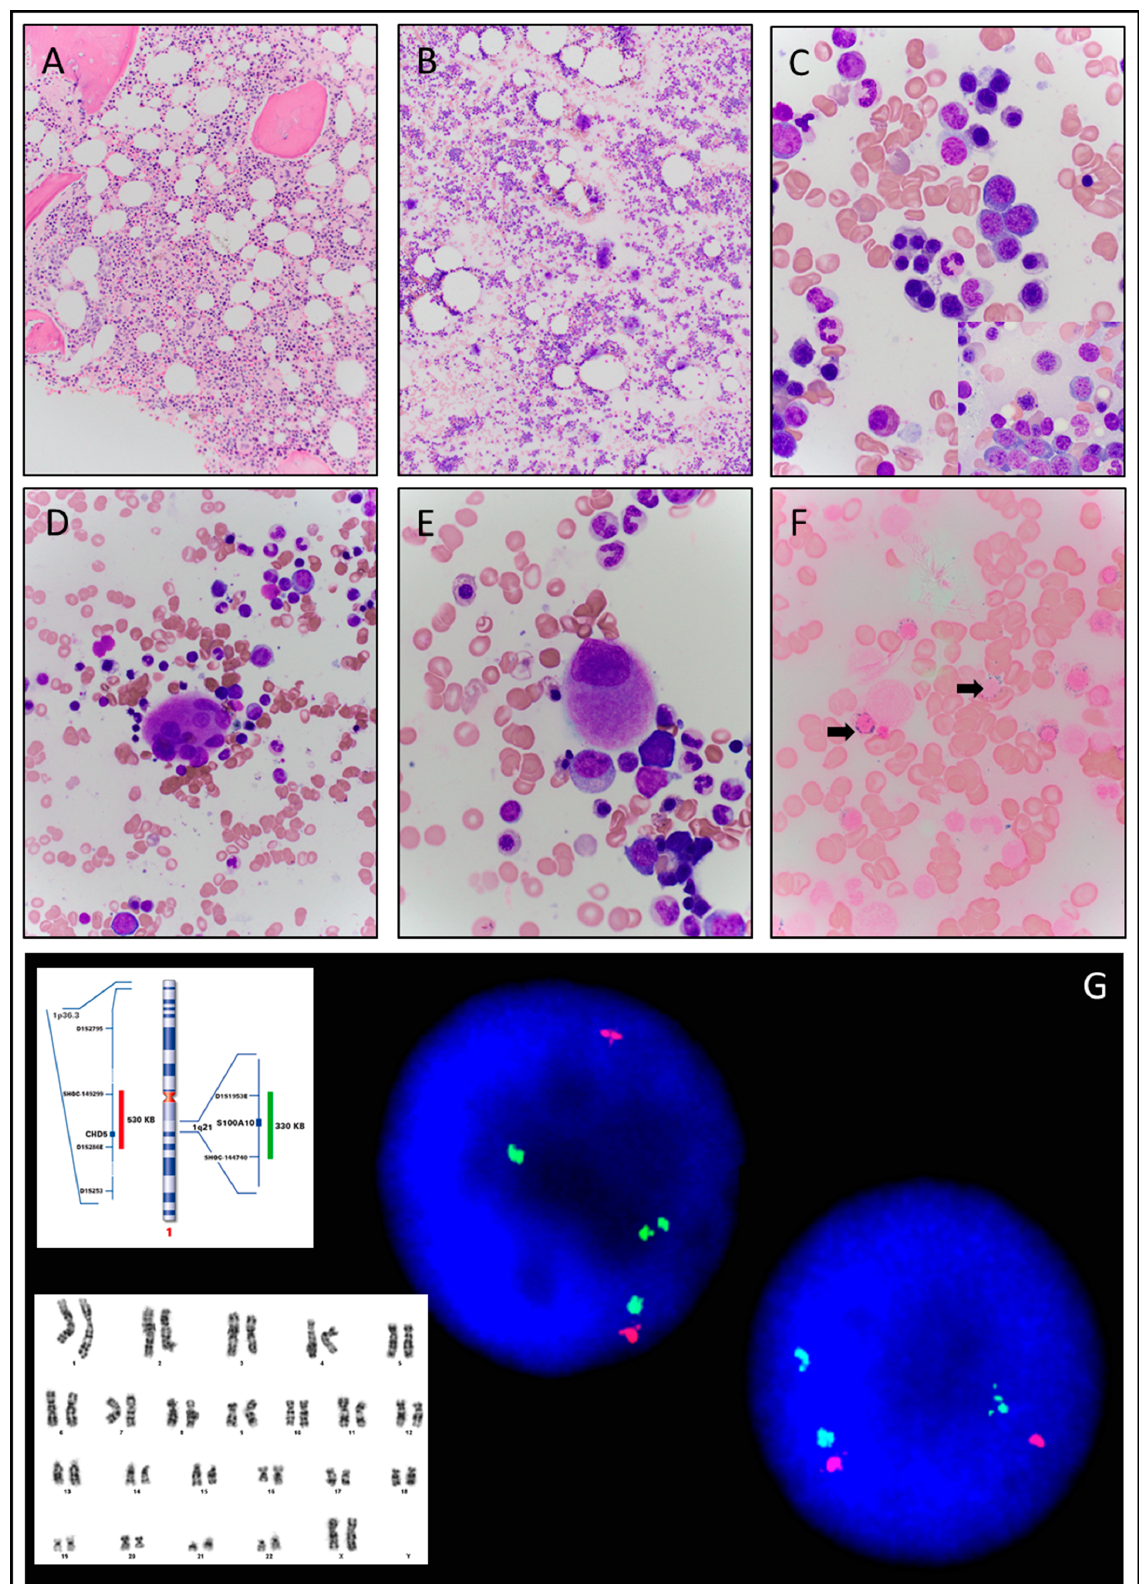
Figure 2. Case 2. ( A ) Bone marrow core biopsy with approximately 50% cellularity (40 × ). ( B ) Bone marrow aspirate with erythroid dominant trilineage hematopoiesis and slightly pleomorphic megakaryocytes (10 × ). ( C ) Erythroid dominant hematopoiesis with dysplasia including